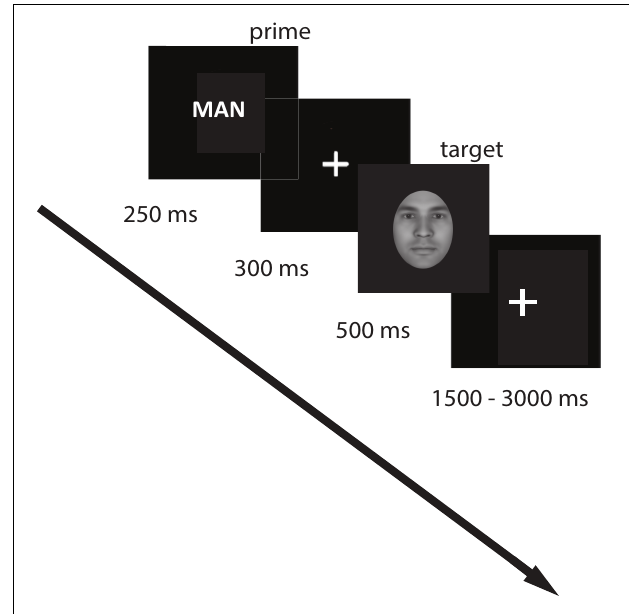
FIGURE 4 | Experimental design. A prime (label or word associated with the target concept) was presented for 250 ms, followed by a fixation cross (300 ms), after which the target picture was presented, followed by a jittered fixation cross for 1500–3000 ms. Participants had to indicate their decision on the gender of the presented face by button